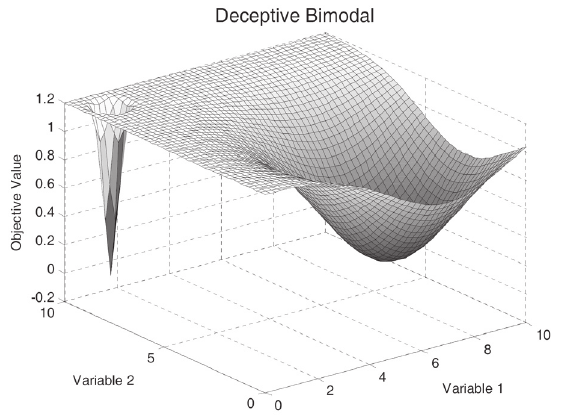
Fig. 4. Deceptive-bimodal function in 2 variables.